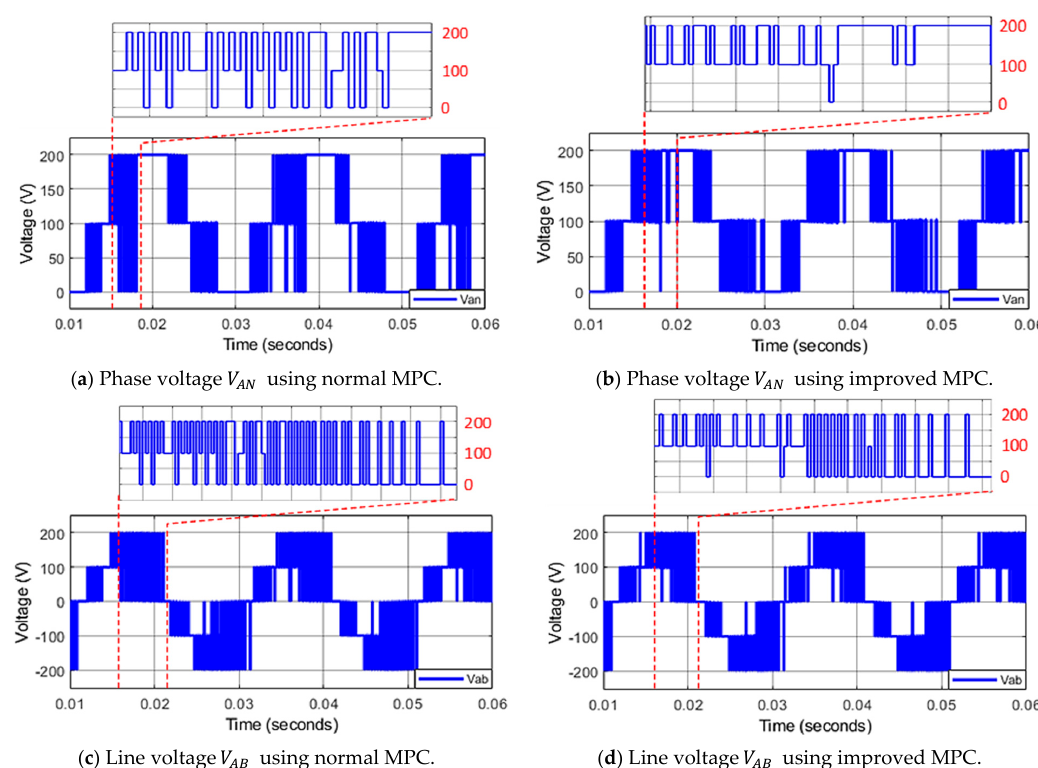
Figure 13. The phase voltage and line voltage using normal MPC and improved MPC for asymmetric 3 − level inverter.